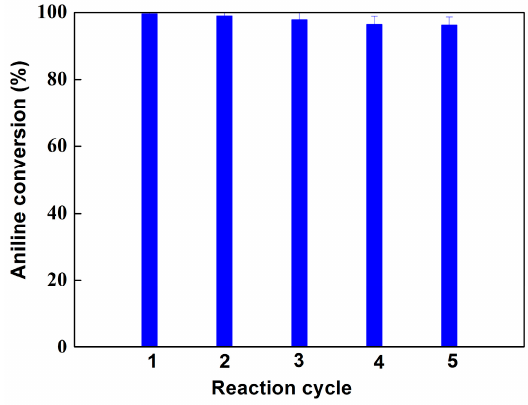
Figure 9. Consecutive use of hematin ‐ MPTS ‐ M ‐ MWCNTs.